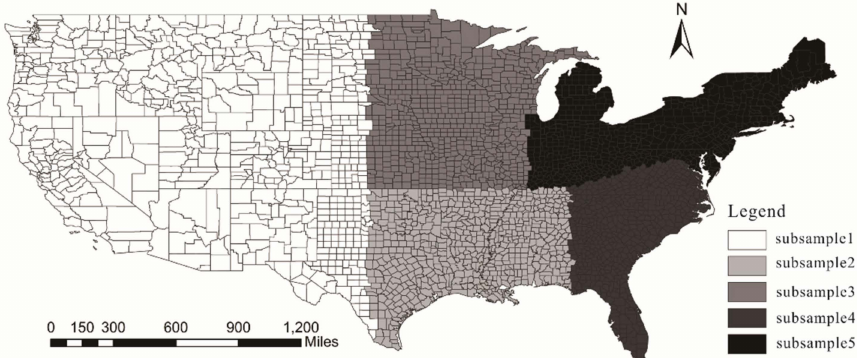
Figure 5. Subsample distribution diagram of the election